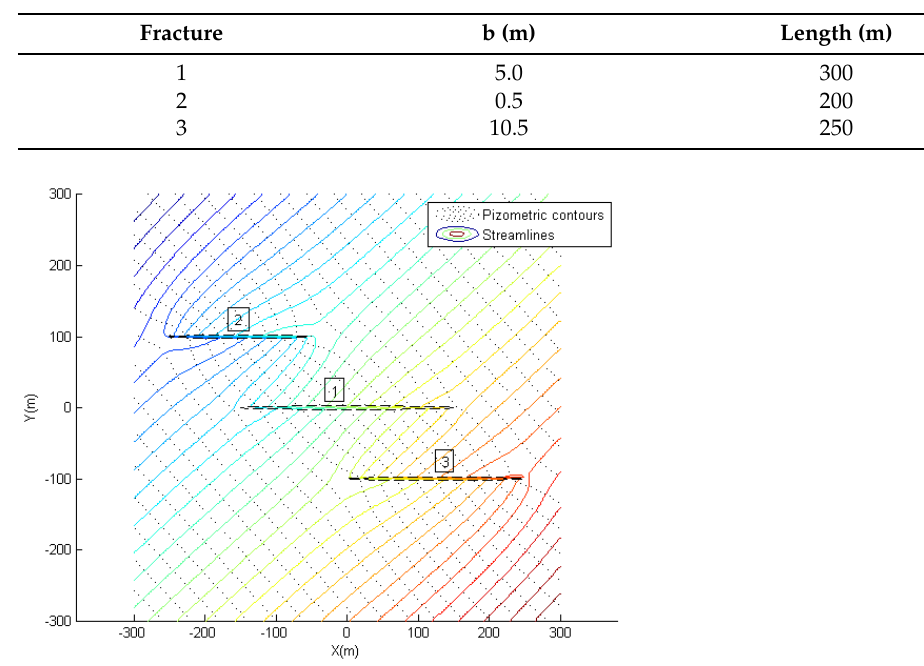
Table 4. Parameters given for Figure 10.